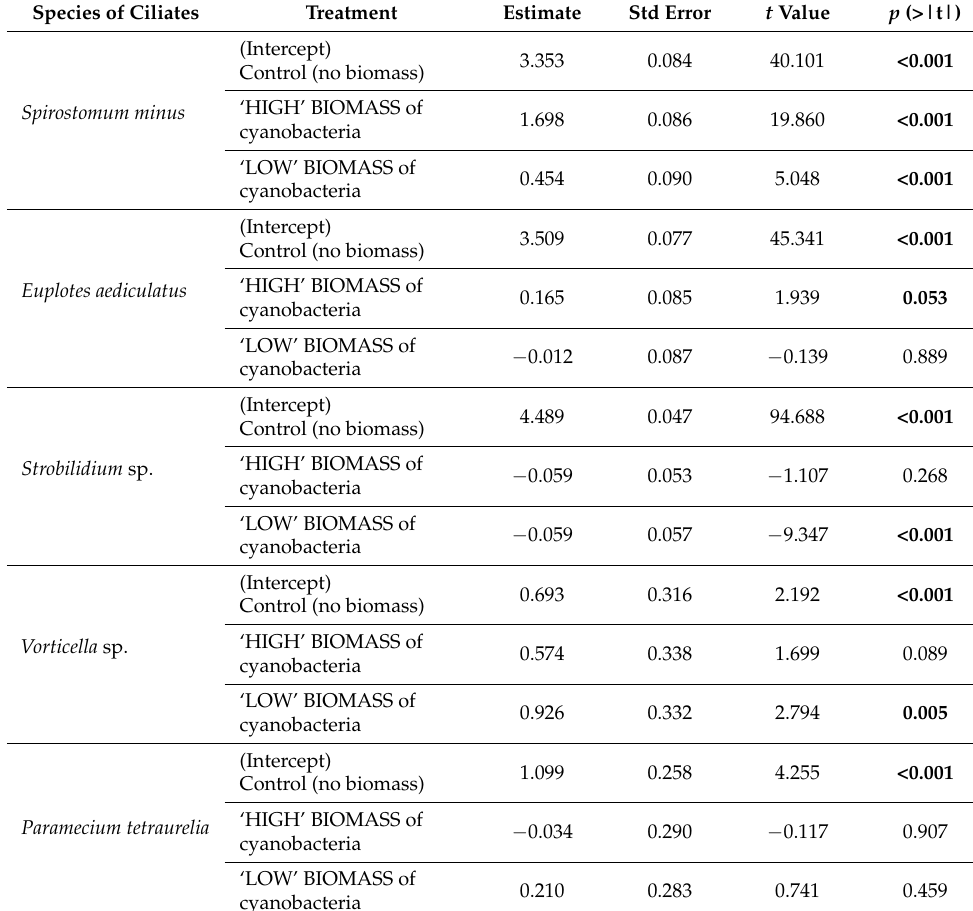
Table 2. The effect of ‘high’ or ‘low’ biomass of A. flos-aquae on the density of ciliate species, p — statistical significances are emboldened.